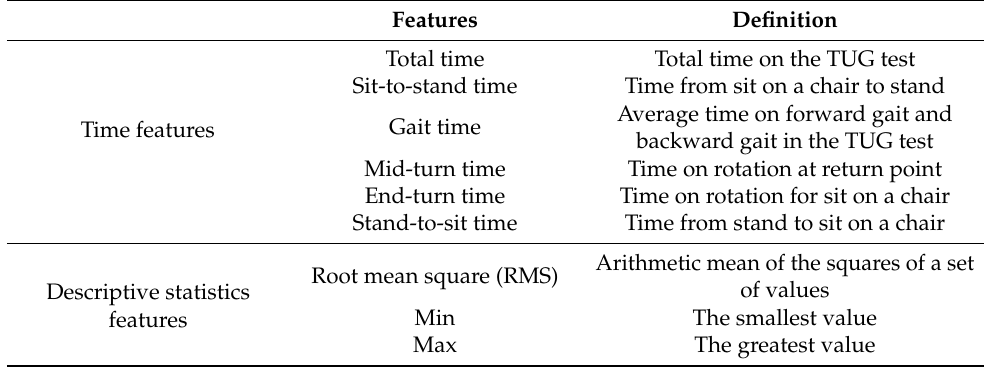
Table 1. Definitions of TUG test